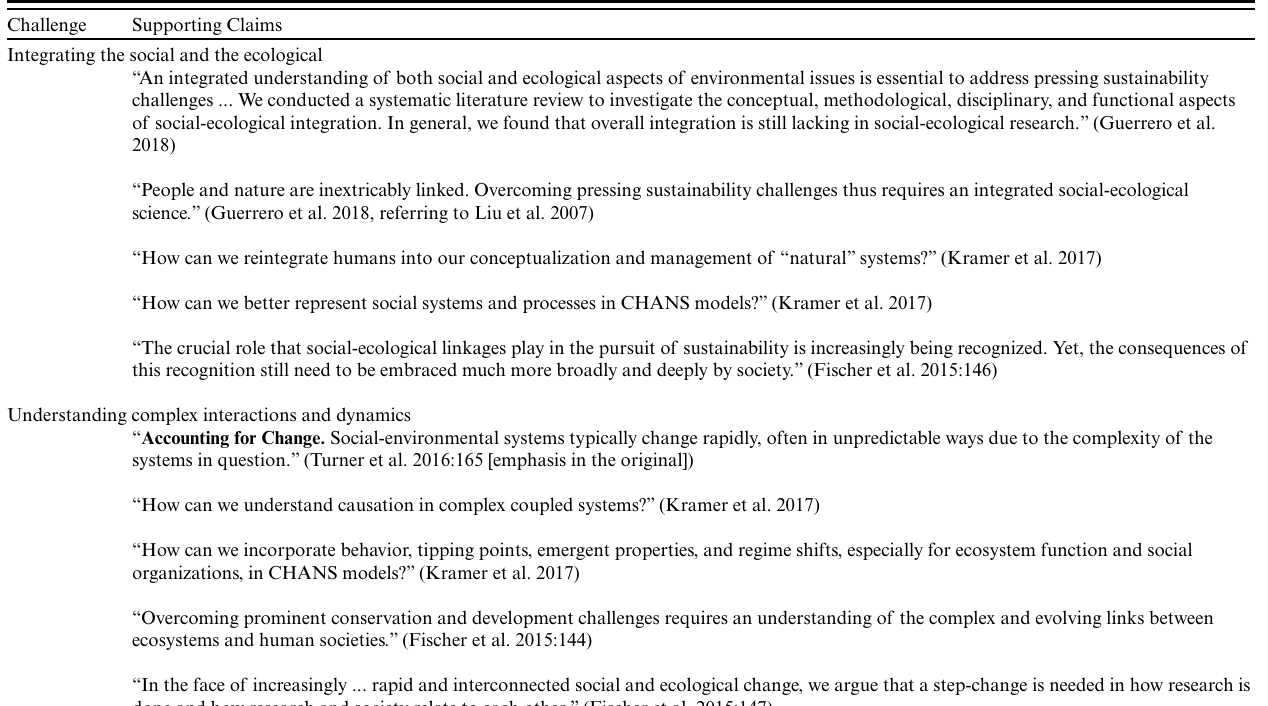
Table 1 . Overview of the challenges and supporting statements. CHANS, coupled human and natural